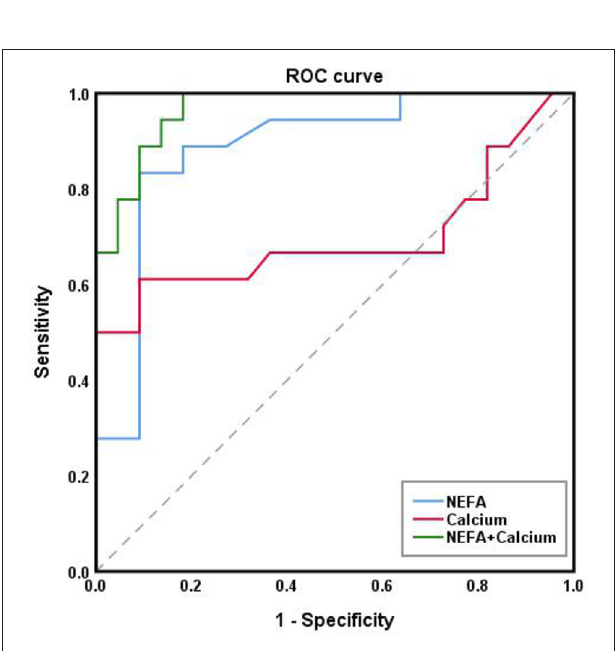
FIGURE 4 | ROC area under the curve of NEFA and calcium in dairy cows with ovarian diseases.